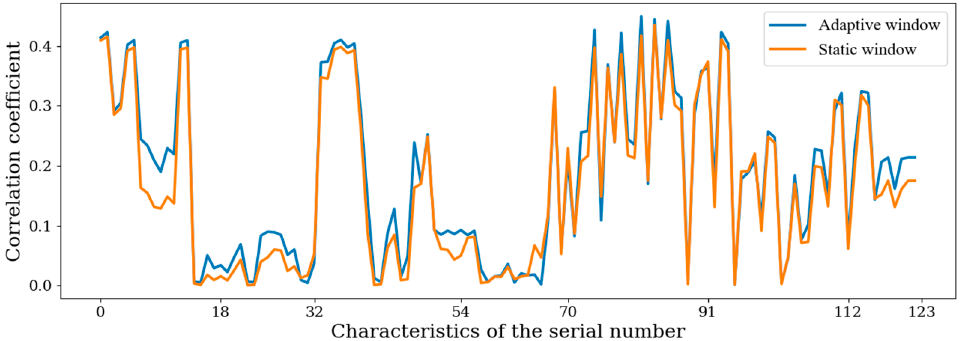
Figure 9. Correlation coefficients between features and emotional labels. Table 2. Average correlation coefficients.